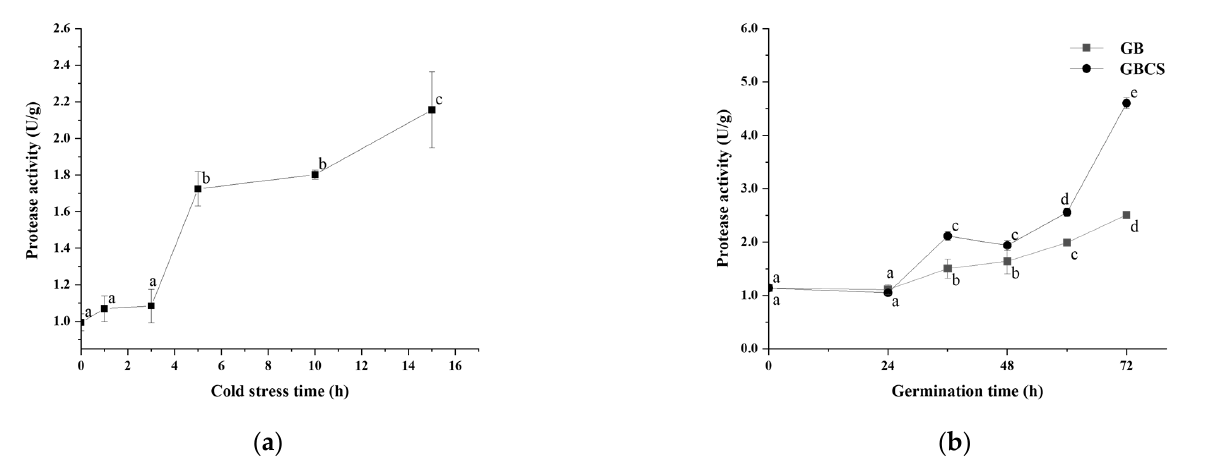
Figure 6. Change in protease activity influenced by cold stress and germination. GB, germinated black rice grain without cold stress; GBCS, germinated black rice grain under cold stress at 0 °C for 1 h; ( a ) represents the change in protease activity influenced by cold stress time; ( b ) represents the change in protease activity influenced by germination time with or without cold stress. Means with di ff erent small le tt er superscripts are signi fi cantly di ff erent at p < 0.05.